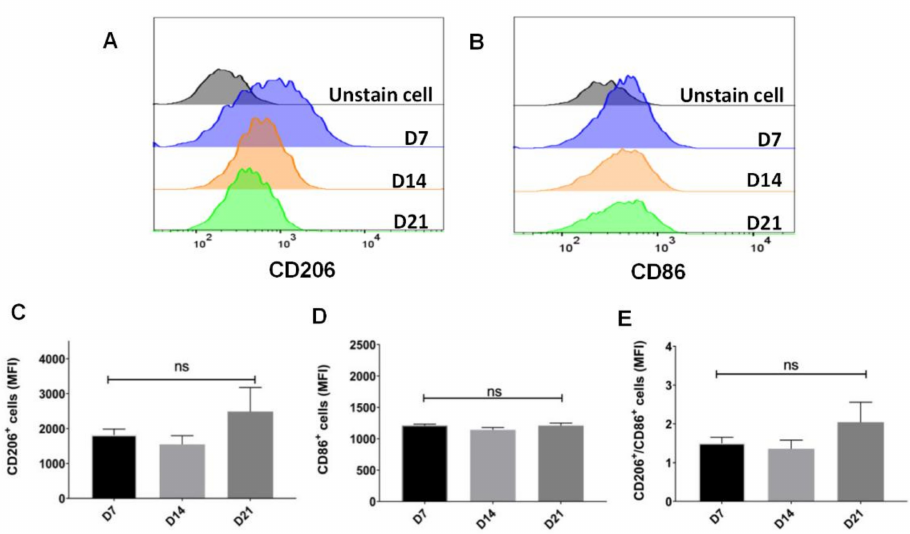
Figure 2. The CD206 expression of single cell on average after withholding of M-CSF supplement. ( A , B ) Flow cytometry analysis of mean fluorescence intensity of CD86 and CD206 as M1 and M2 markers, respectively, on total macrophages treated with M-CSF (D7) and after supplemental with- drawal (D14 and D21). ( C , D ) Statistics of mean fluorescent intensity of CD86 and CD206 surface makers on total macrophages. ( E ) Statistics of mean fluorescent intensity of CD206/CD86 ratio on total macrophages. Data are mean ± SD ( n = 3).